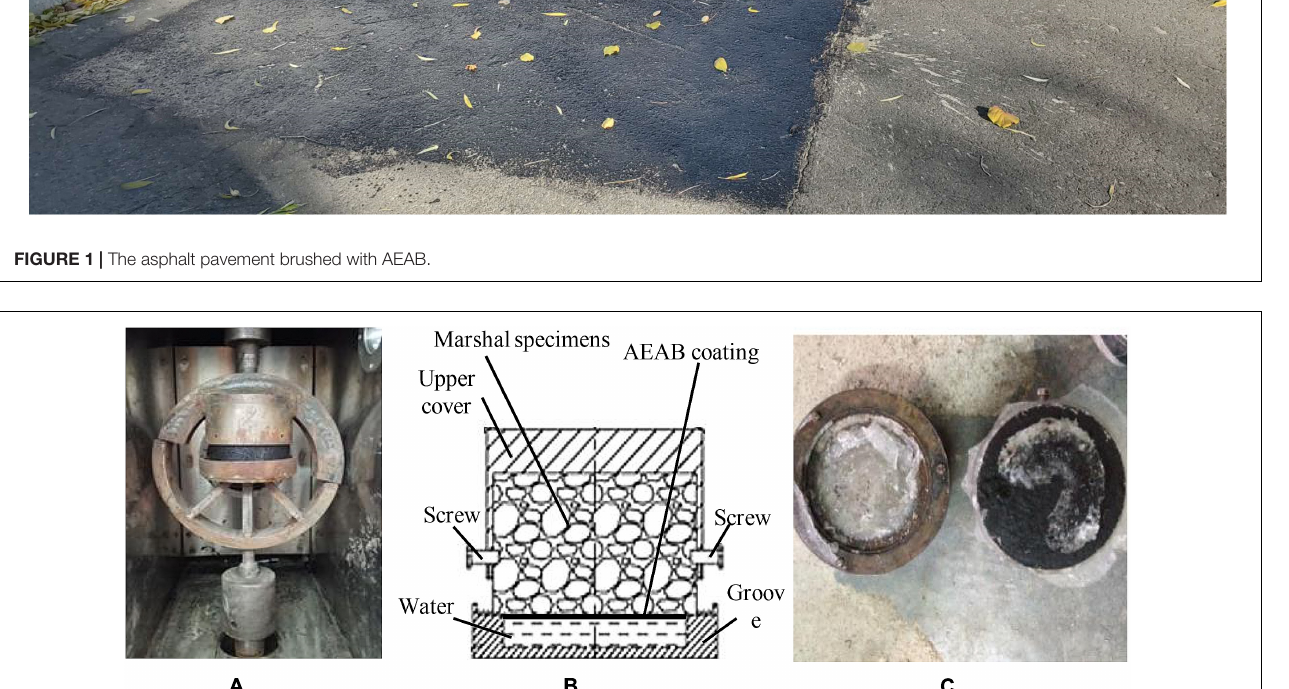
FIGURE 2 | Ice-road adhesion test: (A) Testing device. (B) The profile of fixed specimen. (C) The damage interface of tested